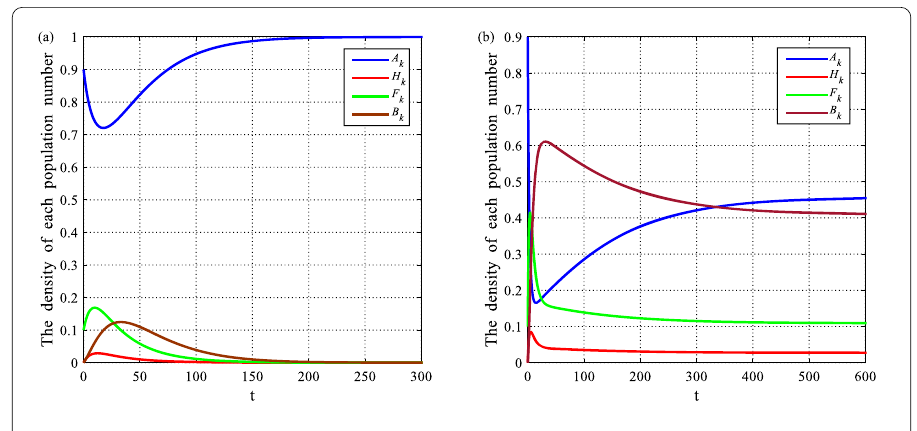
Figure 4 Population changes for each compartment over time when R 0 < 1 ( a ) and R 0 > 1 ( b )